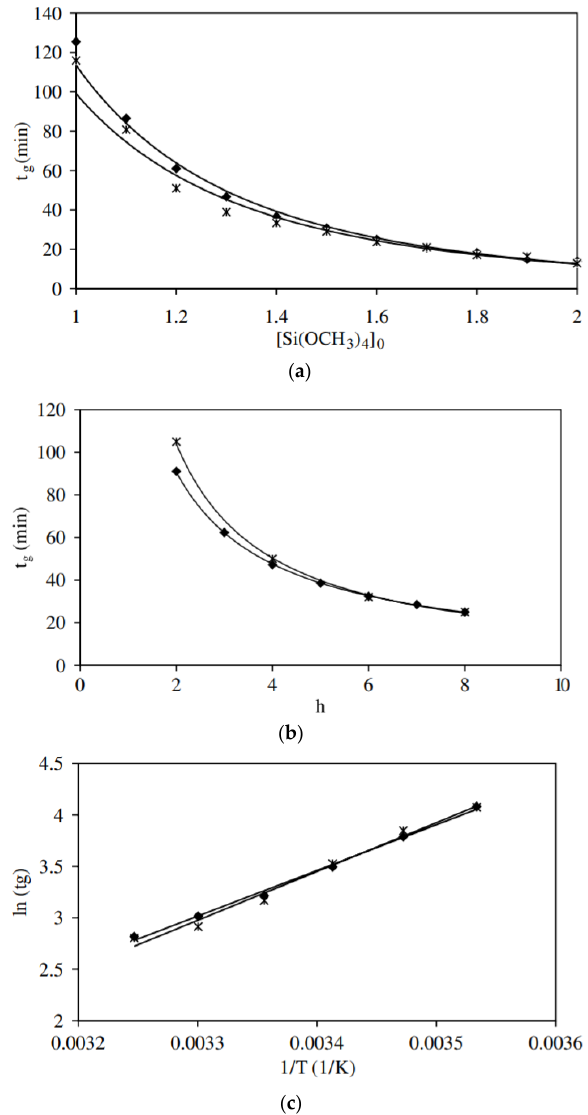
Figure 16. The gelation time ( t g ) of the TMOS at different ( a ) initial concentrations of TMOS, ( b ) water/silane ratios ( r or h ), and ( c ) temperatures. Reprinted with permission from [85]. Copyright Elsevier, 2003.